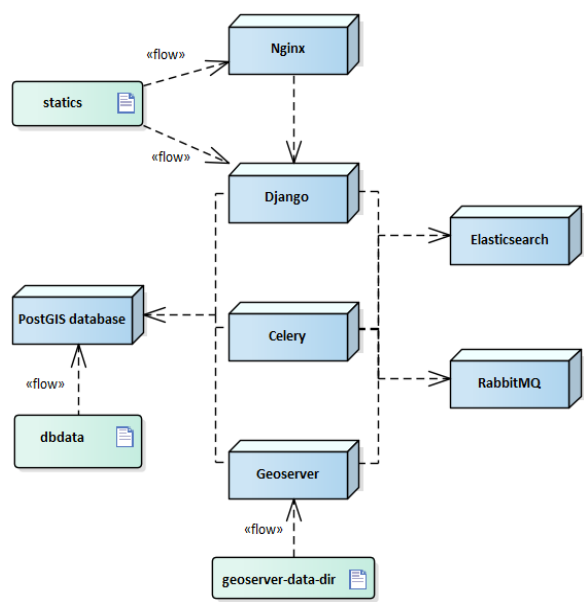
Figure 5 . GeoNode Docker setting for Development.